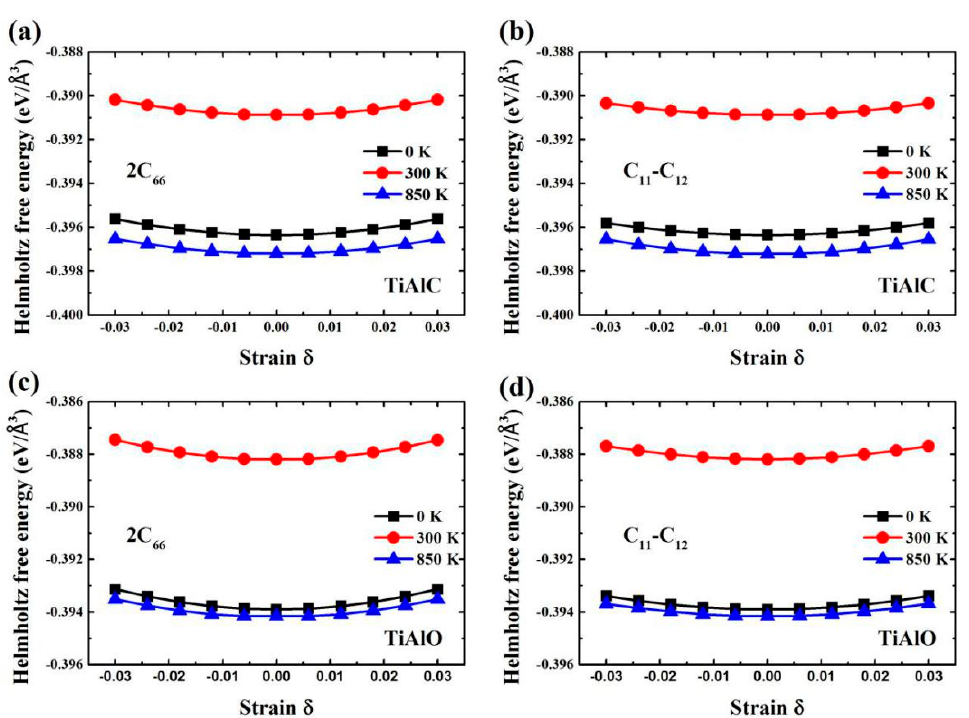
Figure 6. The relationship between Helmholtz free energy and strain δ upon temperature for ( a ) C 11 -C 12 of TiAlC, ( b ) C 66 of TiAlC, ( c ) C 11 -C 12 of TiAlO and ( d ) C 66 of TiAlO, respectively.